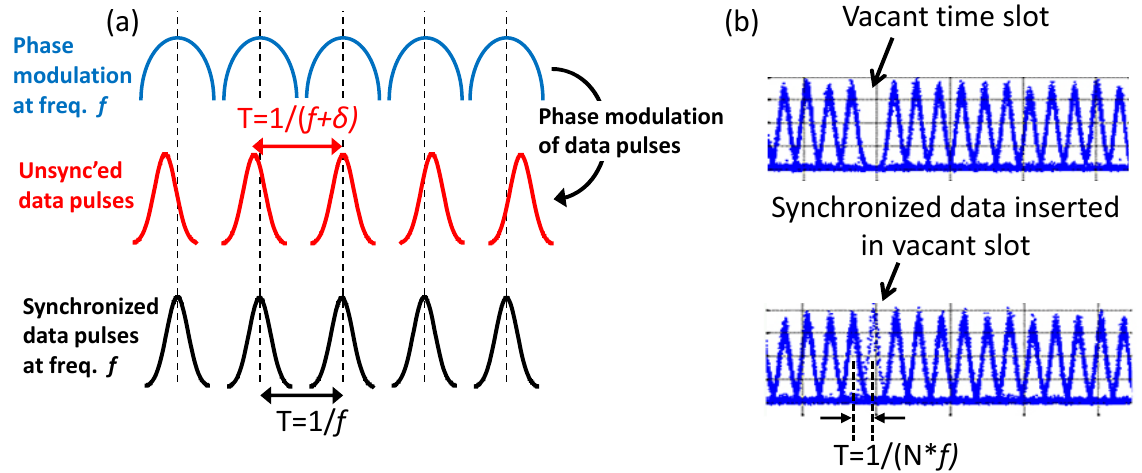
Figure 4. ( a ) Illustration of the operating principle of optical data synchronization. Phase modulation (marked in blue) is applied to the data signal (marked in red) which is at a pulse rate slightly offset from the target clock frequency f . After propagation through a dispersive medium the data pulses acquire the pulse rate f (marked in black); ( b ) Result of multiplexing a synchronized data packet into a vacant time slot in a high speed data